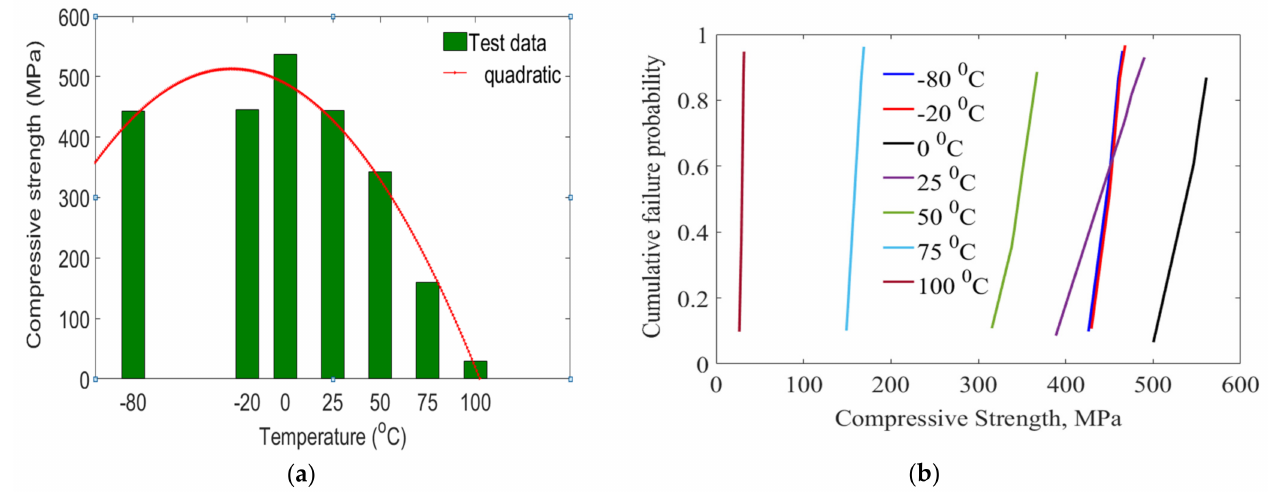
Figure 2. Laminates under different temperatures, ( a ) compressive strength properties ( b ) cumulative failure